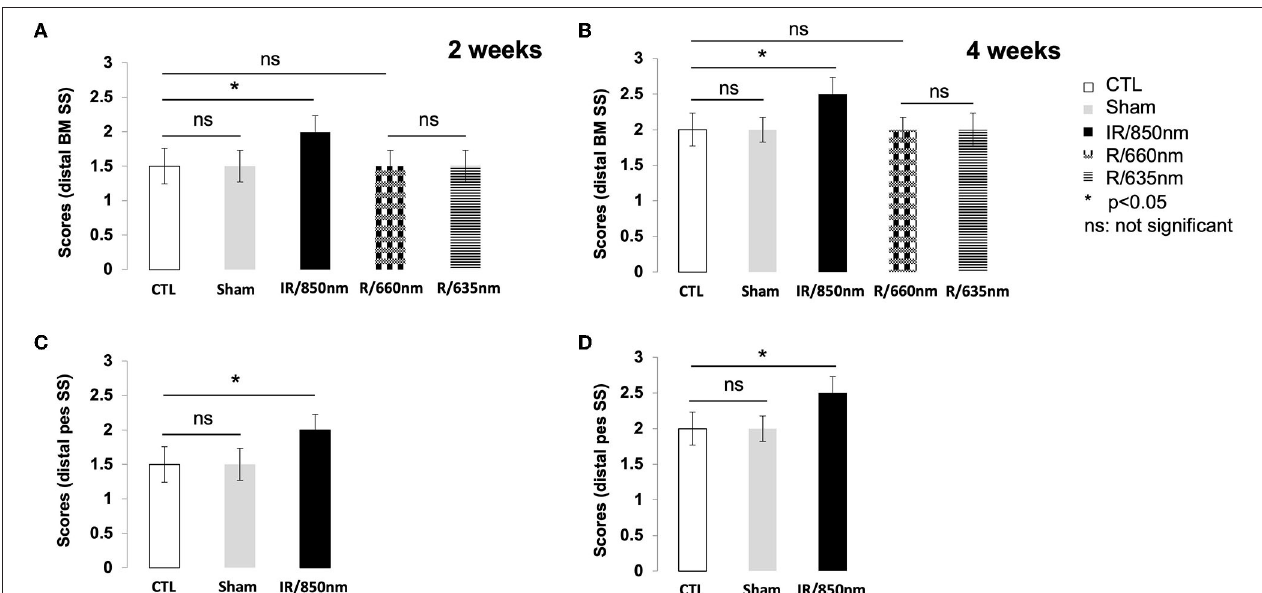
FIGURE 3 | Graph of scores for whisker movements. Functional results 2 and 4 weeks after surgery. (A) Whisker movements after distal section-suture of the buccal and marginal mandibular branches in the different groups [control ( n = 12): operated untreated group, sham ( n = 8): operated untreated group exposed to isoflurane anesthesia ( n = 12), IR treated group ( n = 12) and red treatment group ( n = 16), with treatments at two different wavelengths] two weeks after surgery. A score of 2 was recovered only in the IR group ( p < 0.05). (B) Whisker movements after distal section-suture of the buccal and marginal mandibular branches in the different groups four weeks after surgery. A score of 2.5 was recovered at day 30 only in the group treated with IR ( p < 0.05). (C) Whisker movements after section-suture of the distal pes in the control group ( n = 12) and IR treated group ( n = 12) two weeks after surgery. A score of 2 was recovered only for the treated mice ( p < 0.05). (D) Whisker movements after section-suture of the distal pes in the control group and the IR treatment group two weeks after surgery and four weeks later. A score of 2.5 was recovered at day 30 only in the group treated with IR ( p < 0.05). [*( p < 0.05); one-way ANOVA].